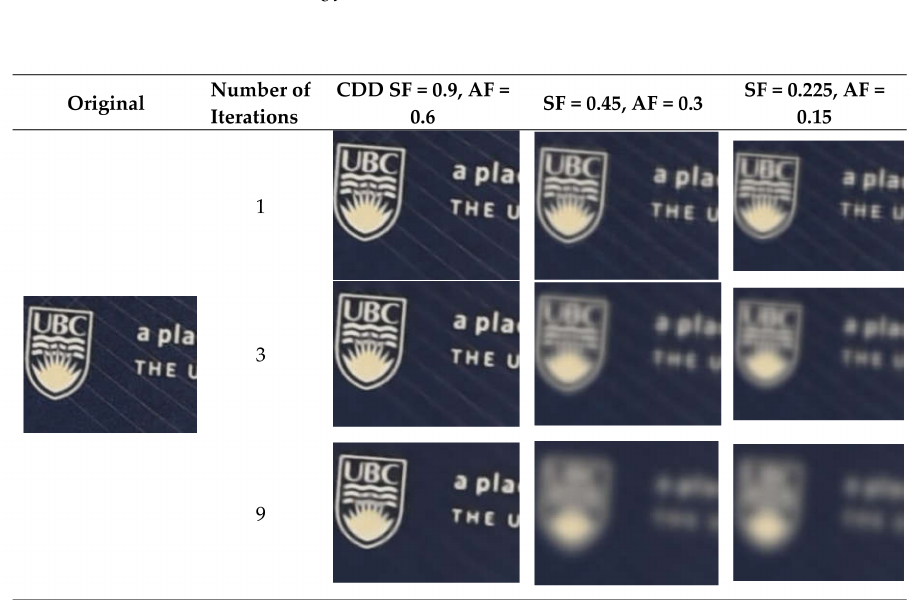
Figure A4. Comparison of the results between the original image from region D in Figure A1 to cases where the Curvature-Driven Di ff usion filter was applied at one, three and nine iterations (rows), in addition to varying sharpness factors (SF) and aspect factors (AF)